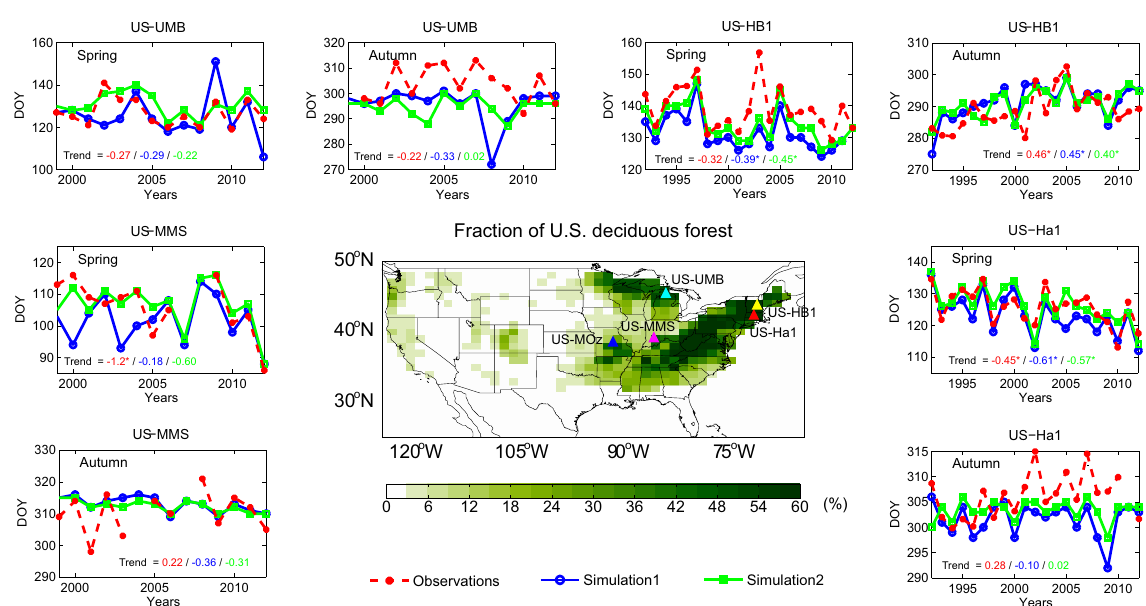
Figure 1. Simulation of spring and autumn phenology at four US deciduous broadleaf forest (DBF) sites. The map shows the fraction of US DBF derived from the Advanced Very High Resolution Radiometer (AVHRR). The area with >3% coverage is the domain for this study. Five triangles indicate the locations of sites whose long-term measurements of meteorology and phenology are used for the calibration and/or validation of the model: Harvard Forest (US-Ha1), Hubbard Brook Forest (US-HB1), Morgan–Monroe State Forest (US-MMS), University of Michigan Biological Station Forest (US-UMB), and Missouri Ozark Forest (US-MOz). Phenological dates are recorded at US-Ha1 and US-HB1 during 1992–2012. Measurements of leaf area index (LAI) and photos are used to derive phenology at US-UMB and US-MMS for 1999–2012. Derived phenological dates at US-MOz are used for model calibration but not validation and are not shown here. At each site, two simulations are performed with the spring model S9 and autumn model A4 (refer to Fig. 2), driven by temperatures from either the in situ measurements (blue) or the Modern-Era Retrospective Analysis for Research and Applications (MERRA) reanalysis (green). Trend of each time series (units in dayyr − 1 ) is shown with colors indicating results from observations (red) and simulations (blue or green). Significant trends ( p <0.05) are marked with